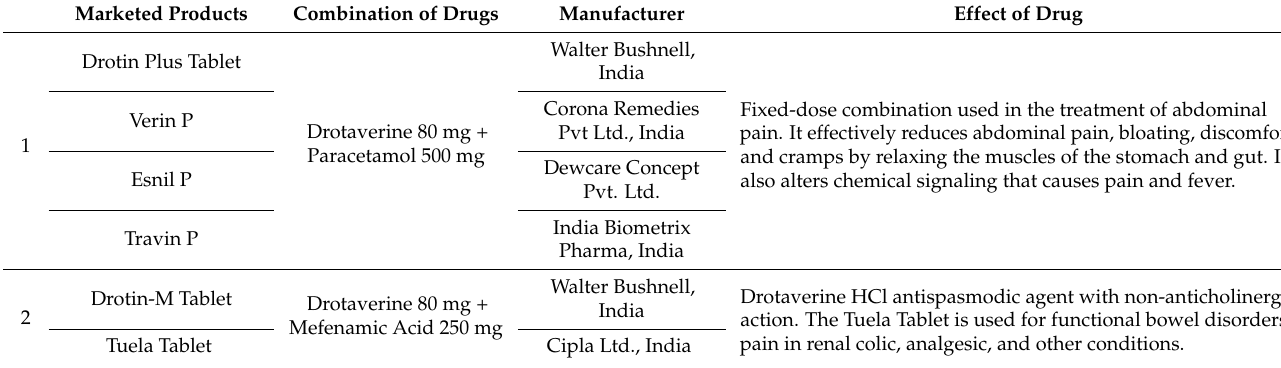
Table 1. Developed combinations of NSAID and antispasmodic